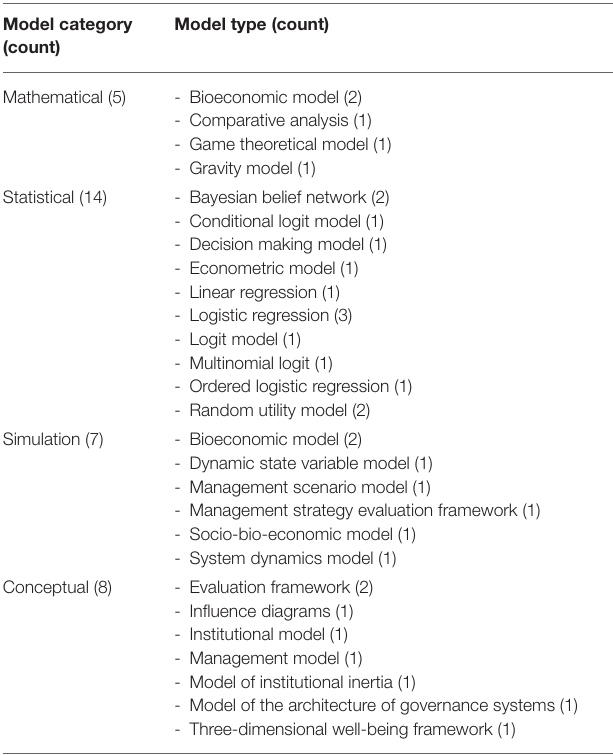
TABLE 3 | Model categories and model types extracted from the publications in this